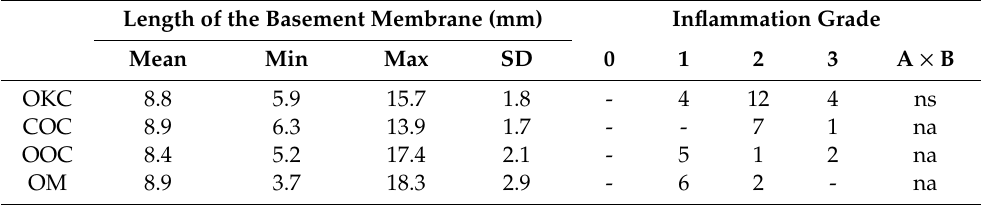
Table 1. Length of the basement membrane and inflammation grade in OKC, COC and OM samples. Length of the Basement Membrane (mm) Inflammation